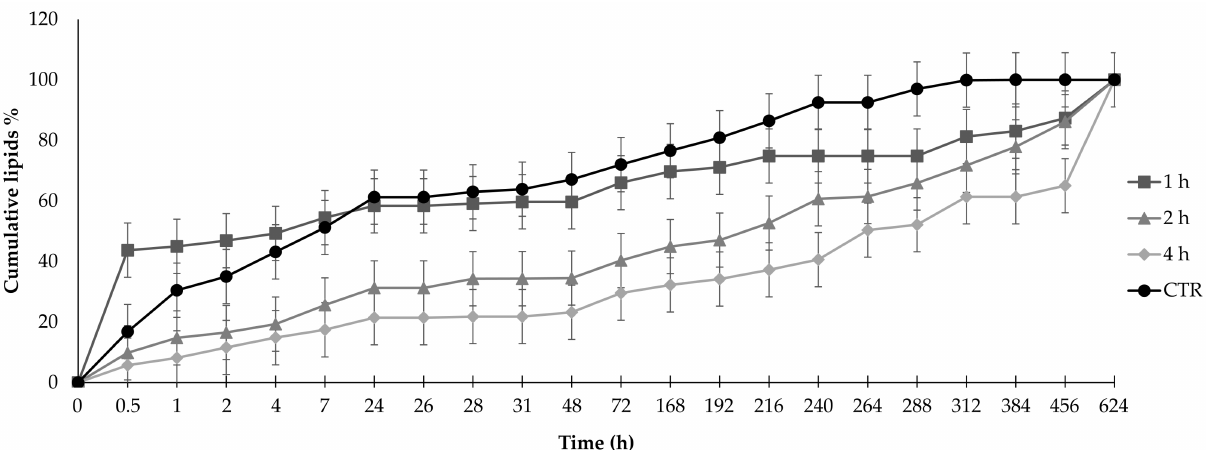
Figure 6. In vitro lipid release profiles from PCL scaffolds immersed in pH 7.2 phosphate-buffered saline (PBS) at room temperature. Comparison of PCL scaffolds without SF (CTR) and with SF degummed for different times (1, 2, or 4 h). Data are reported as mean values ± LSD, multifactor ANOVA, n = 3. The time on the x axis is not in scale, to better visualize the curves and the error bars. The overlap of two LSD intervals graphically indicates the absence of significant difference ( p >